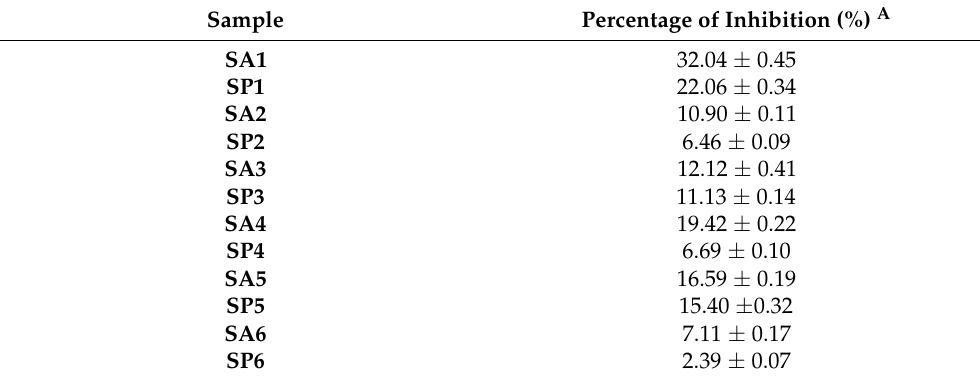
Table 6. Percentage of anti-collagenase activity of SP1 – SP6 and SA1 – SA6 (at 400 µ g/mL).